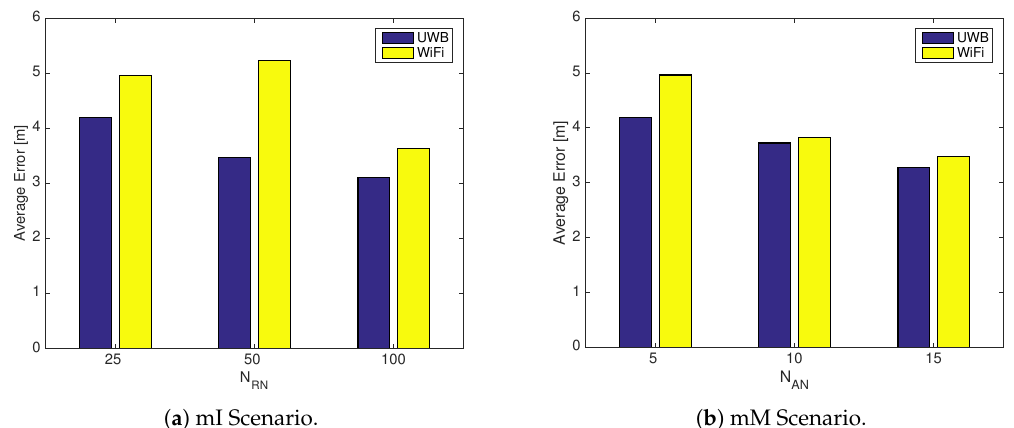
Figure 10. Average positioning error (cid:101) in minimum infrastructure (mI) ( a ) and minimum measurements (mM) ( b ) scenarios for ultra-wideband (UWB)-combo vs WiFi-opt. Complexity Comparison —The comparison between the complexity of WiFi-opt and